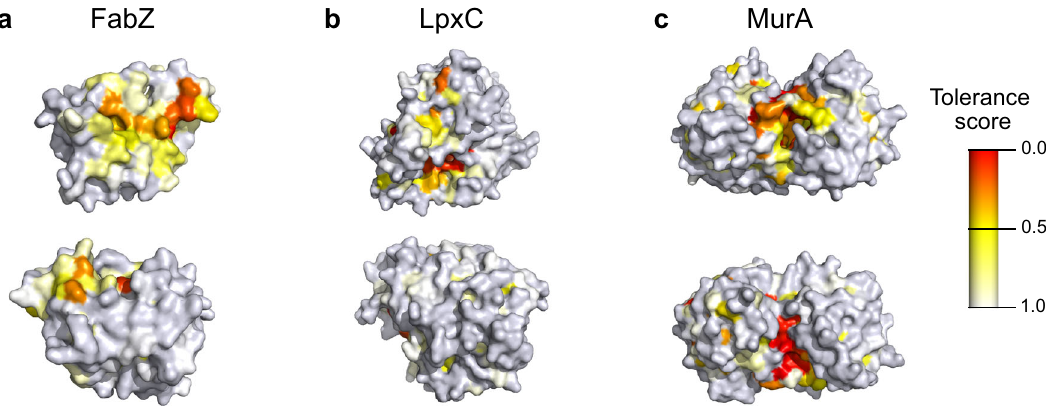
Fig. 6 | Protein structures colored by each residue ’ s tolerance score reveal regions essential for protein function that can be targeted by antimicrobial compounds. Tolerance scores calculated here were plotted onto experimentally determined protein structures for FabZ, PDB 6n3p ( a ); LpxC, PDB 4mqy ( b ); and